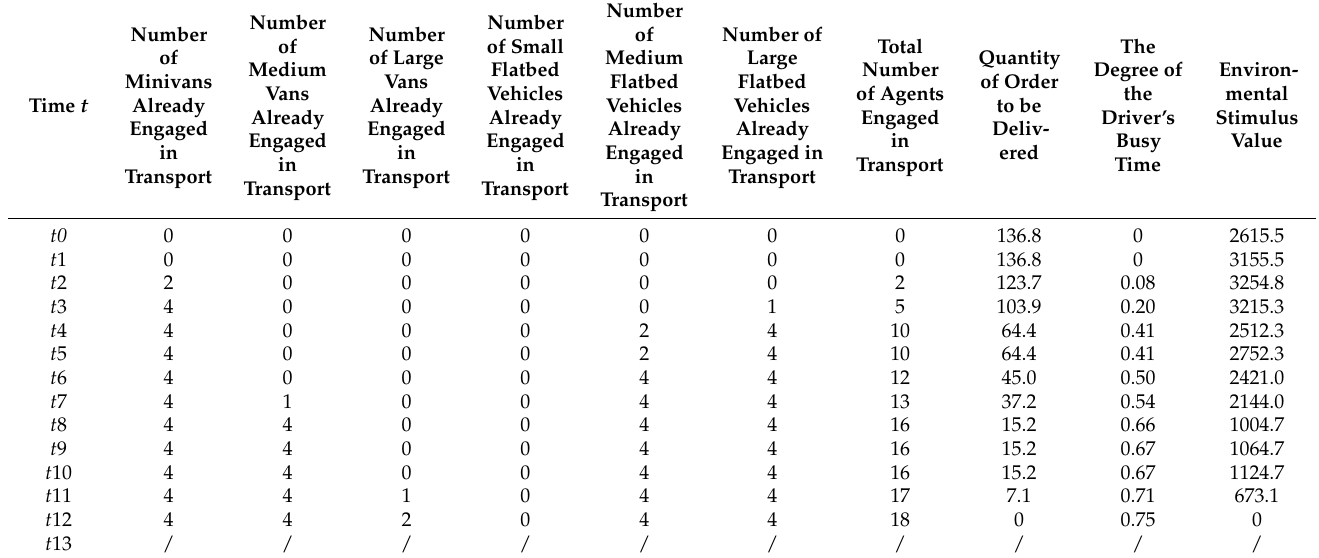
Table 5. Operation results of the extended ant colony division of labor